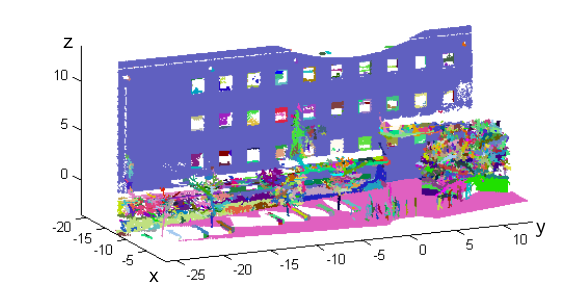
Figure 4. Segmentation result (unit:m)